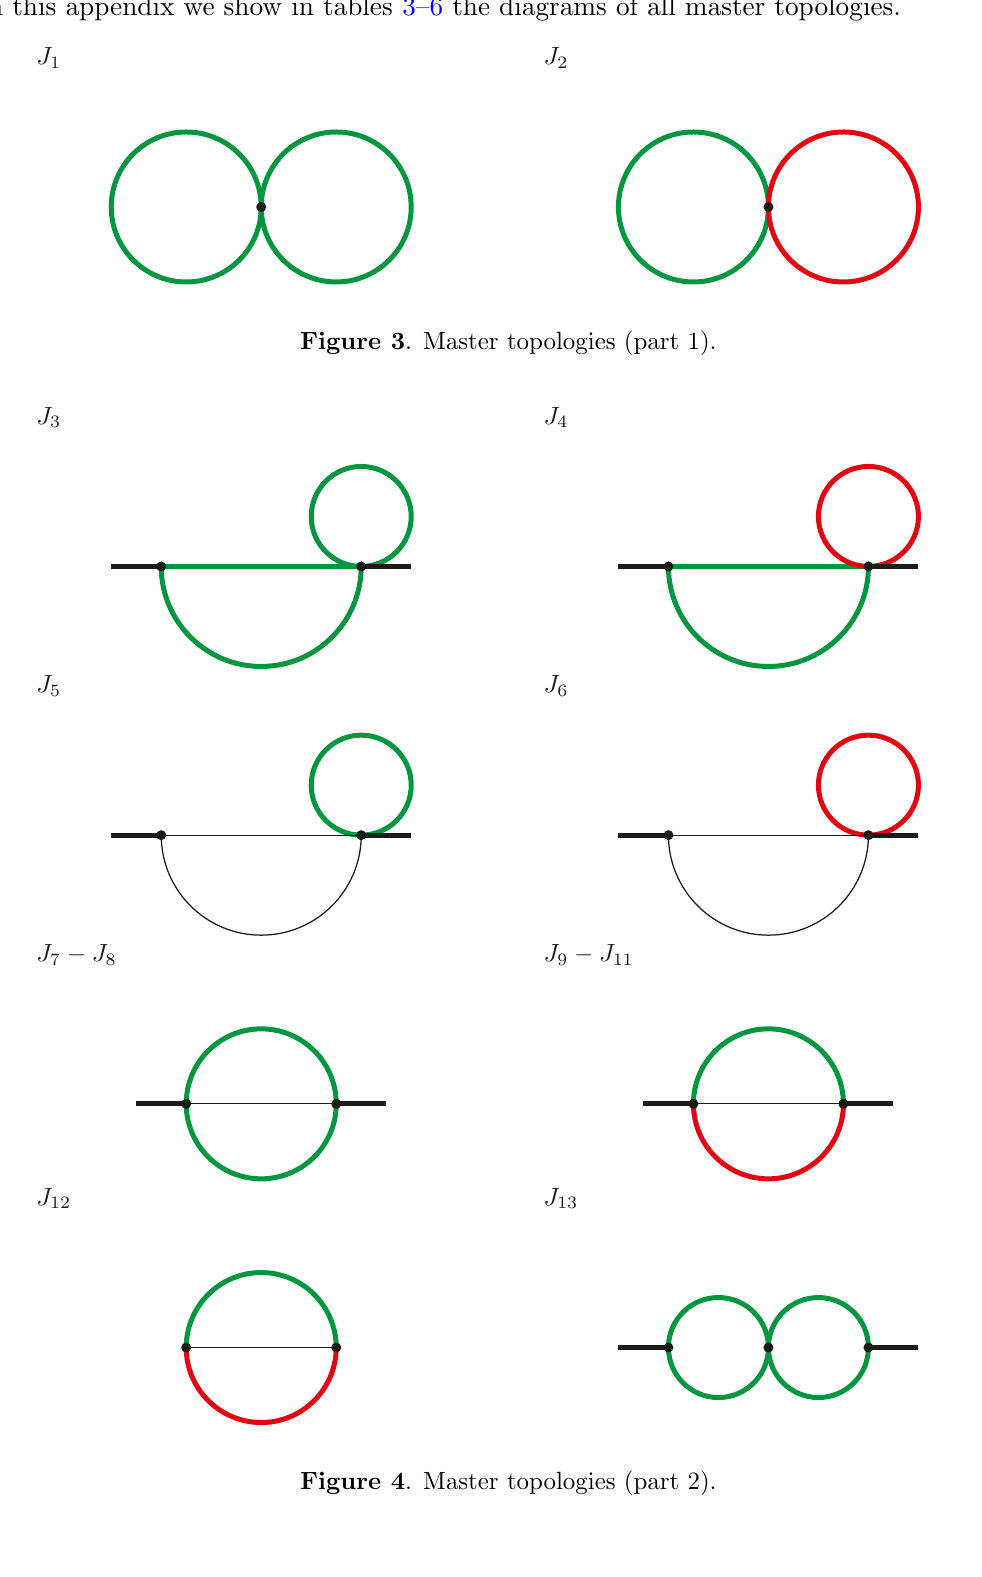
Figure 4 . Master topologies (part